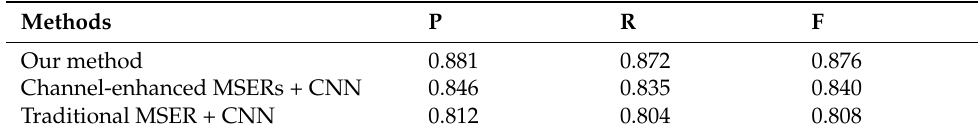
Table 2. The evaluation results in uyghur text